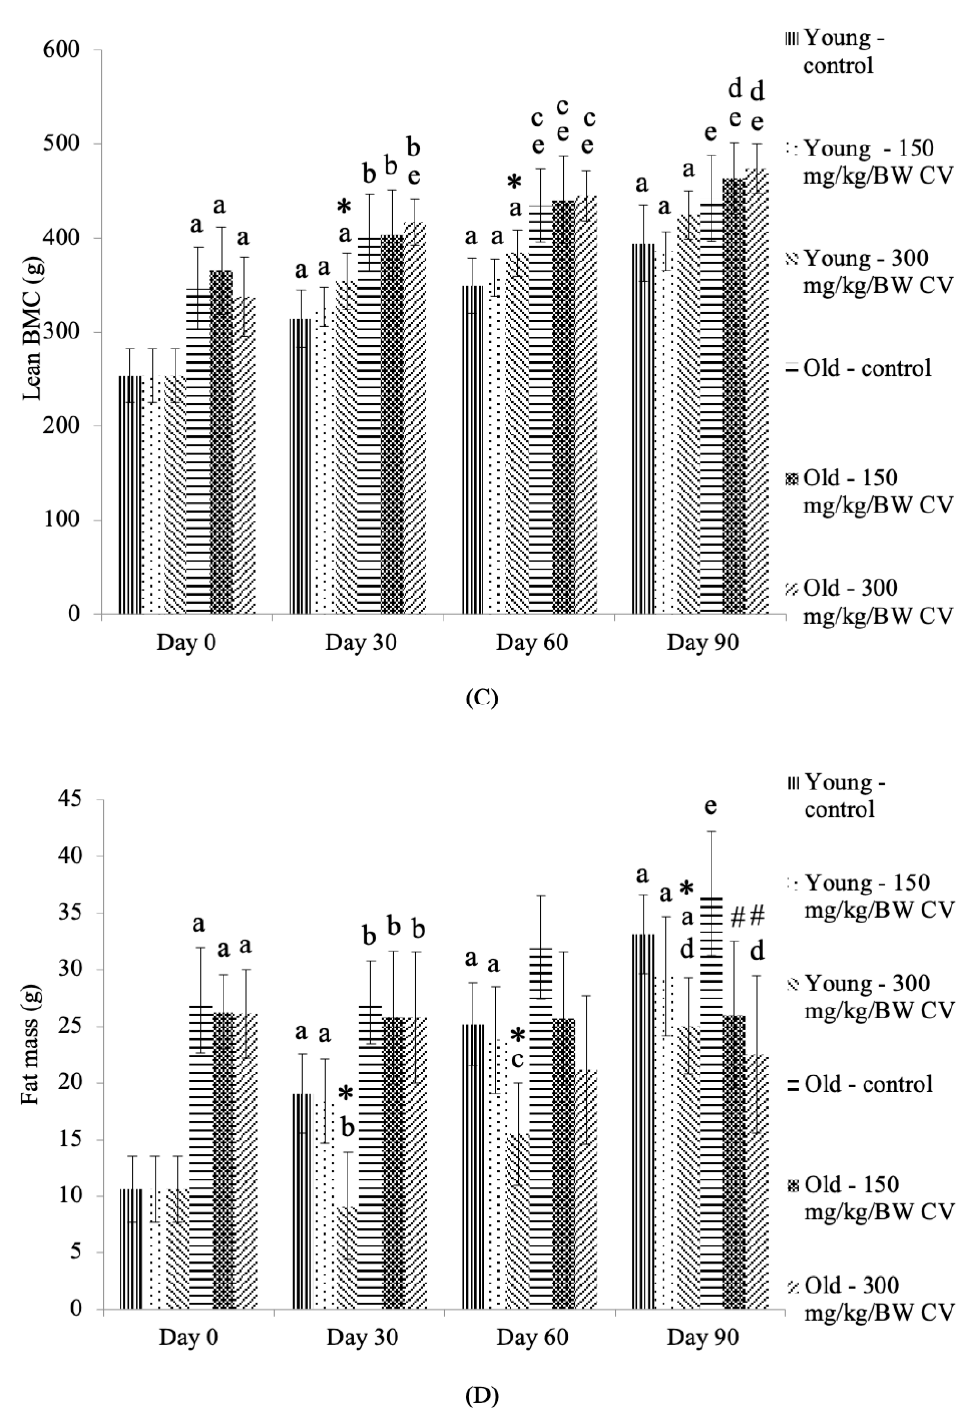
Figure 3. The ( A ) bone mineral content (BMC), ( B ) bone mineral density (BMD), ( C ) lean BMC and ( D ) fat mass of the young and old rats. Data are presented as the mean ± SD, n = 8 (control rats), n = 10 ( C. vulgaris -treated rats). * p < 0.05 significantly di ff erent compared to the control young rats on the respective day, # p < 0.05 significantly di ff erent compared to the control old rats on the respective day, a p < 0.05 significantly di ff erent compared to the control young rats on Day 0, b p < 0.05 significantly di ff erent compared to the control young rats on Day 30, c p < 0.05 significantly di ff erent compared to the control young rats on Day 60, d p < 0.05 significantly di ff erent compared to the control young rats on Day 90, e p < 0.05 significantly di ff erent compared to the control old rats on Day 0, with a post hoc Tukey HSD test. BW: Body weight; CV: C.